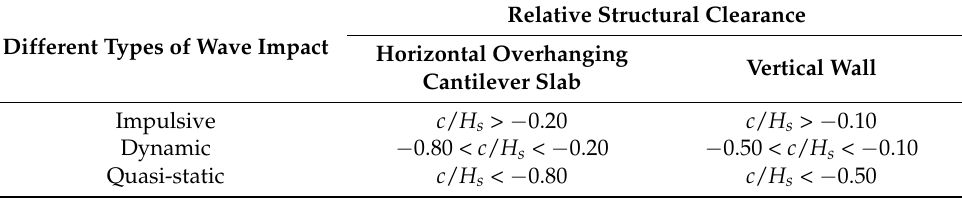
Table 5. Classification of dominant wave impact type on relative clearance.